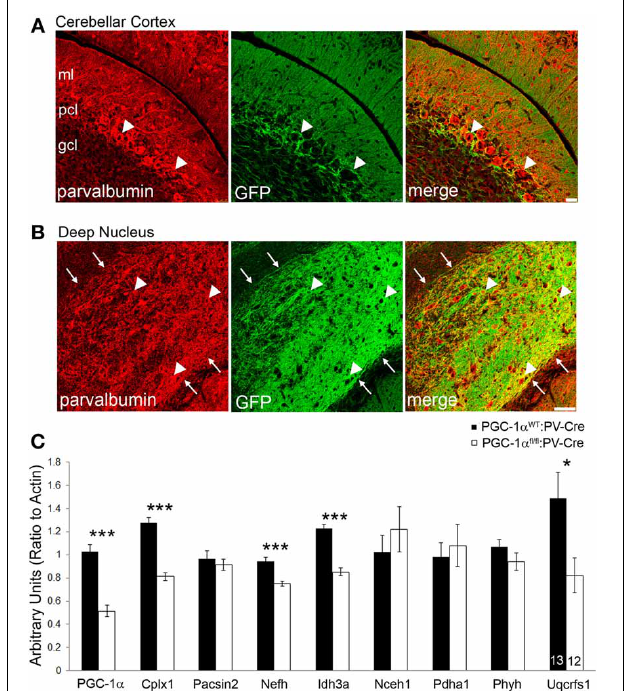
FIGURE 6 | Conditional deletion of PGC-1 α in PV-positive cells decreases transcript expression of novel cerebellar PGC-1 α -dependent genes. To conditionally delete PGC-1 α in a manner consistent with its reported expression (i.e., Purkinje cells, inhibitory interneurons of the cerebellar cortex, and cells of the deep cerebellar nuclei) PGC-1 α floxed mice were crossed with mice expressing Cre recombinase driven by the parvalbumin promoter (PV-Cre). PV-Cre mice were crossed with mutant tomato/mutant green reporter mice to determine the specificity of Cre-mediated recombination at 3 months of age. PV expression is pseudocolored red from Cy5. (A) Green fluorescent protein (GFP) expression was high in the Purkinje cell layer (PCL; arrowheads), moderate in the molecular layer (ML), and low in the granule cell layer (GCL). Scale bar = 25 μ m. (B) GFP expression was greatest in the deep cerebellar nuclei (interposed nucleus shown) and exhibited a high degree of colocalization to PV-positive terminals and, to a lesser extent, PV-positive cell bodies (arrowheads). Note the absence of GFP expression outside the borders of the nucleus (arrows). Scale bar = 75 μ m. (C) Gene expression of PGC-1 α and its putative targets was measured in cerebellar homogenates from 6-month-old PGC-1 α WT and fl / fl mice expressing PV-Cre by q-RT-PCR. Expression of PGC-1 α , Cplx1, Nefh, Idh3a, and Uqcrfs1 were significantly reduced in PGC-1 α fl / fl :PV-Cre mice. One-tailed t -tests. ∗∗∗ p < 0 . 0005 , ∗ p < 0 . 05 . n/group indicated on last bar histogram. Data presented as mean ± SEM. Gene expression was measured by q-RT-PCR in